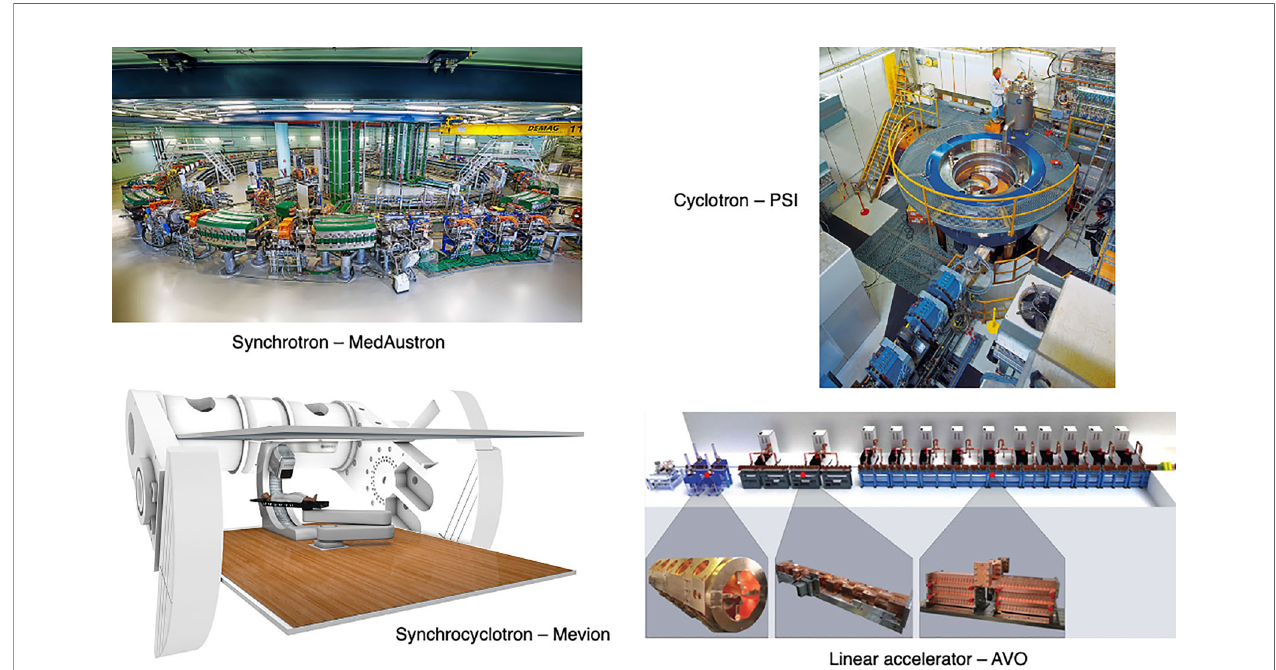
FIGURE 6 | Synchrotron at the MedAustron facility (43) and COMET cyclotron (for PBT) at PSI (44). Gantry-mounted Mevion S250i synchrocyclotron (Mevion Medical Systems, Inc.). Depiction of the AVO LIGHT LINAC with the radiofrequency quadrupole, side coupled drift tube LINAC and coupled cavity LINAC sections highlighted